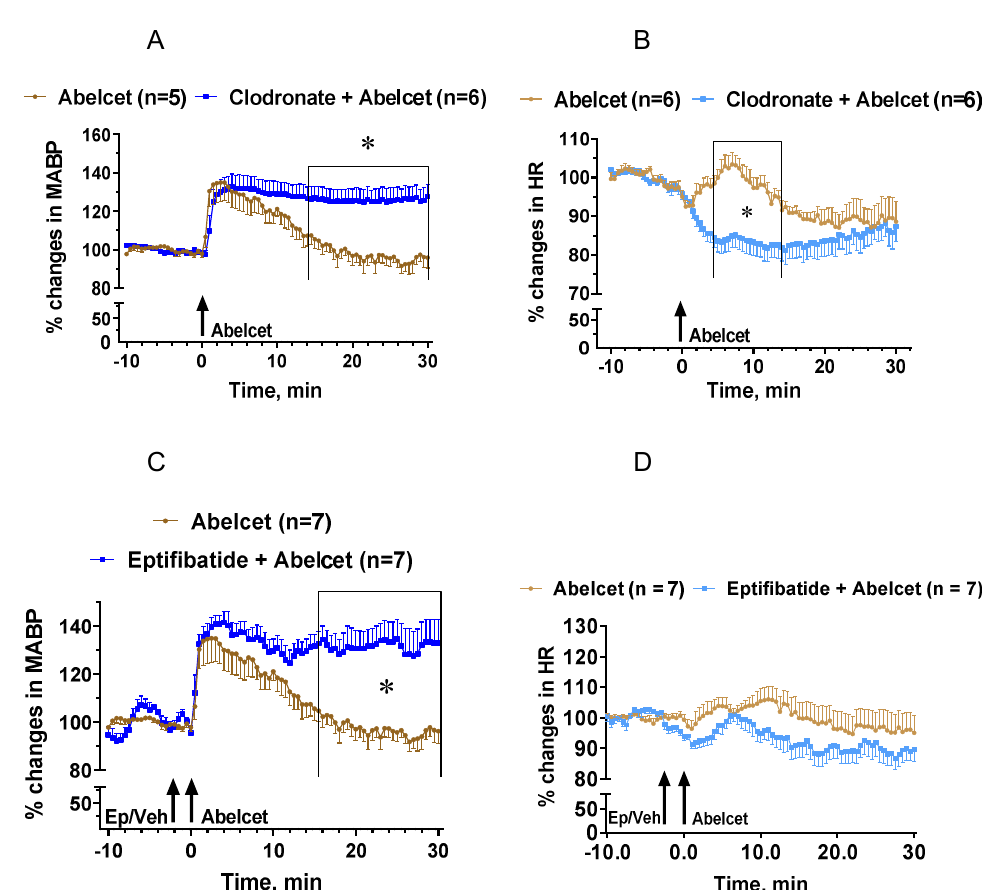
Figure 4. Effects of macrophage depletion with clodronate liposomes and platelet glycoprotein IIb/IIIa receptor inhibition with eptifibatide on the Abelcet-induced changes in MABP and HR in anesthetized NMRI mice. The time of treatment with eptifibatide or its vehicle and Abelcet injection is indicated by arrows. Clodronate or empty liposomes were injected via the tail vein at 200 mL/mouse (containing 1 mg clodronate) two days before the experiment. ( A , C ) Mean arterial blood pressure (MABP); ( B , D ) heart rate (HR). ( A , B ) Macrophage depletion with clodronate liposomes; ( C , D ) treatment with eptifibatide. Veh: vehicle. * p < 0.05. Vehicle- and clodronate- and eptifibatide-treated groups were compared using two-way ANOVA for repeated measurements followed by Dunnet’s multiple comparison tests. Macrophage depletion with clodronate liposomes lengthened the increase in MABP from min 12 after Abelcet administration, and decreased HR from 4 to 14 min after Abelcet administration. Treatment with eptifibatide lengthened the increase in MABP from 16 min after Abelcet administration but did not alter HR.